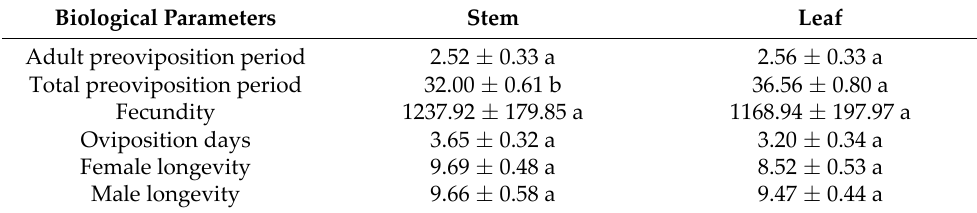
Table 2. Adult longevity and reproductive parameters of S. litura fed on different tissues of